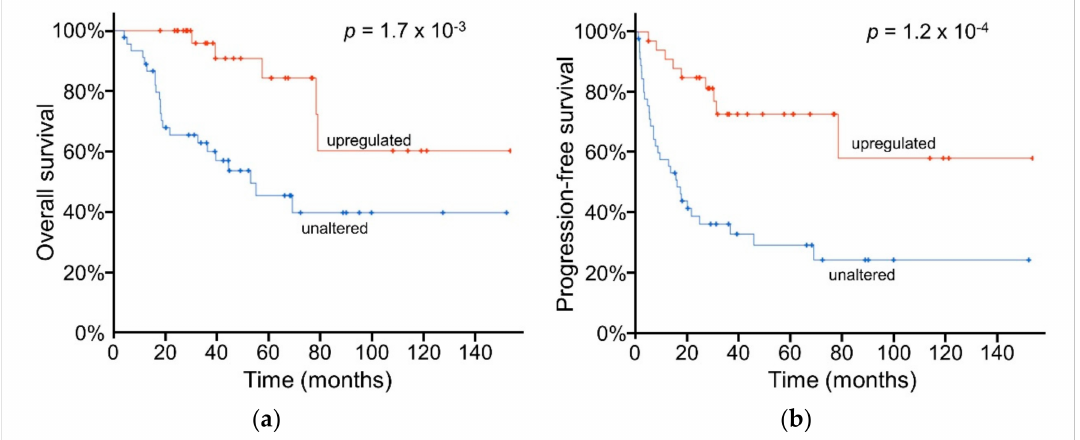
Figure 2. Kaplan-Meier survival estimates of patients with upregulated vs unaltered tumoral ABAT transcript expression. ( a ) overall survival and ( b ) progression-free survival in patients with tumors expressing upregulated ABAT transcripts ( n = 33); relative to unaltered ABAT transcripts ( n = 45), log-rank tests. Plots generated by cBioPortal,